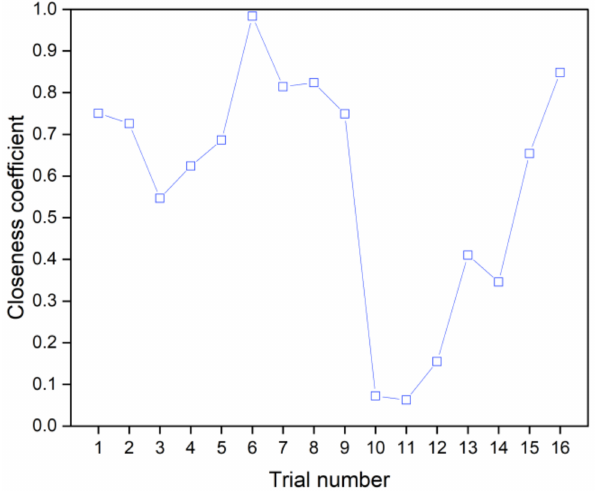
Figure 3. Closeness coefficients of the alternatives in TOPSIS for case study